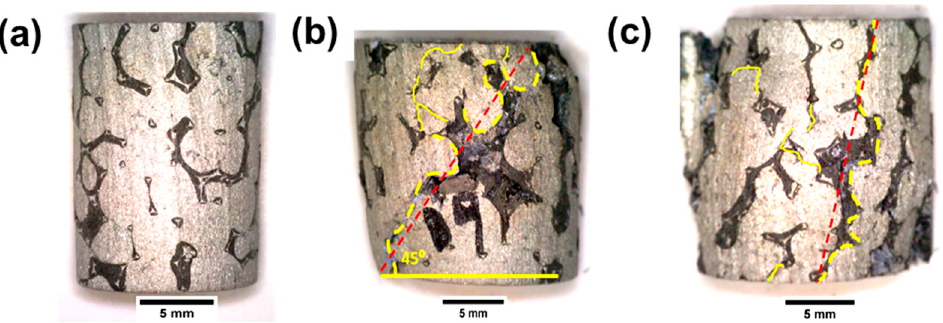
Figure 8. Macroscopic fractography of C4 composites: ( a ) composite without compression; ( b ) composite crack lines showing shear failure; and ( c ) composite crack lines showing vertical splitting failure.